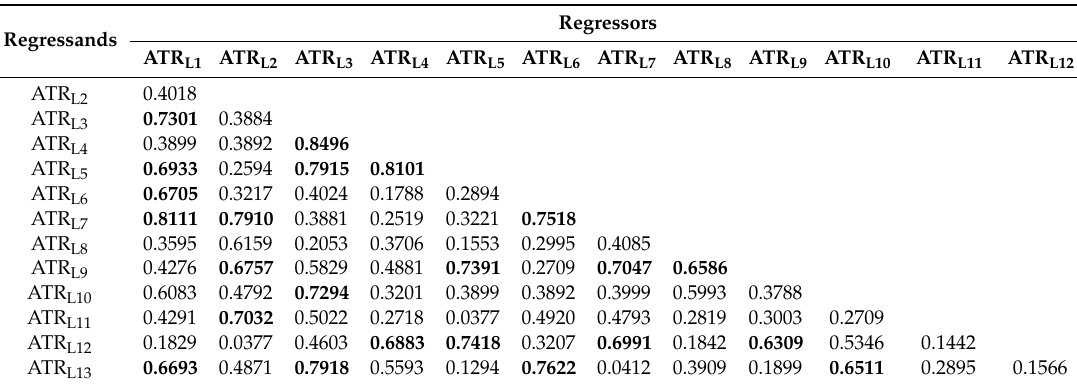
Table 6. Correlation matrix for type IV